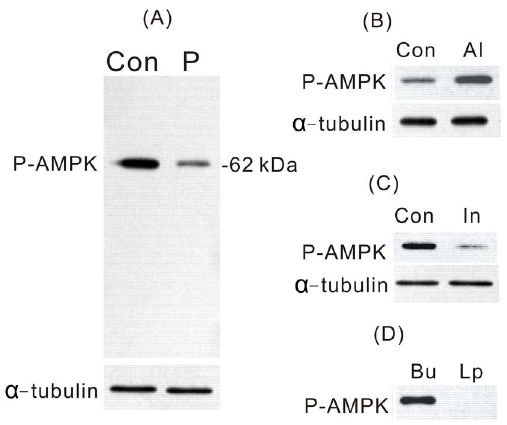
Figure 3. Effects of PTTH (A), AICAR (B), compound C (C), and lambda protein phosphatase (D) on AMPK phosphorylation. Con, glands incubated in control medium; P, glands incubated in medium containing PTTH; Al, glands incubated in medium containing 1 mM AICAR; In, glands incubated in medium containing 10 m M compound C; Bu, glands treated with buffer only; Lp, glands treated with lambda protein phosphatase. Results shown are representative of two independent experiments.